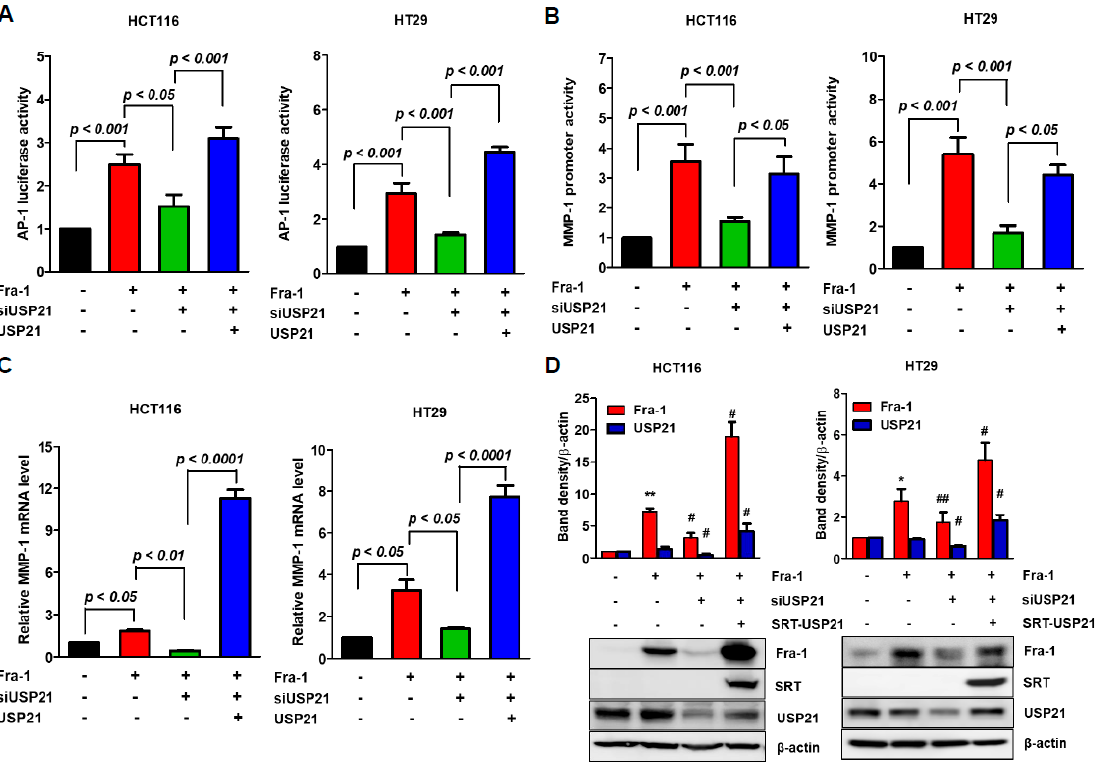
Figure 4. USP21 regulates Fra-1 activities. ( A , B ) HCT116 and HT-29 cells were transfected with scrambled siRNA (control) or siUSP21 for 24 h and then co-transfected with plasmids encoding Fra-1 or SRT-USP21 as indicated. After introducing AP-1 (A) or MMP-1 reporter plasmid (B) for an additional 24 h, luciferase transcriptional responses were measured in each cell line. Data were statistically analyzed by one-way ANOVA ( n = 3). ( C ) After transfection with indicated plasmids into HCT116 and HT-29 cells, MMP-1 mRNA expression was quantified by real time-PCR with normalization to GAPDH. Values are fold-increases relative to the control, and error bars represent mean ± SD. Data were statistically analyzed by one-way ANOVA ( n = 4). ( D ) HCT116 and HT-29 cells were